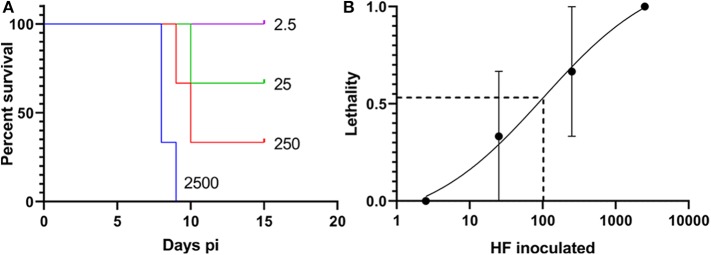
LD50 of the Wild-type (WT) HF strain. (A) Kaplan-Meier survival curves for WT HF bacteria, number of inoculated bacteria/mouse is shown for each curve, N = 3, Log-rank, Gehan-Breslow-Wilcoxon test among each group: P < 0.01. (B) Sigmoidal curve showing the calculation of WT HF culture. LD50 is based on survival with 10-fold dilutions, calculated from AAT Bioquest LD50 calculator, with means and standard error (N = 3).